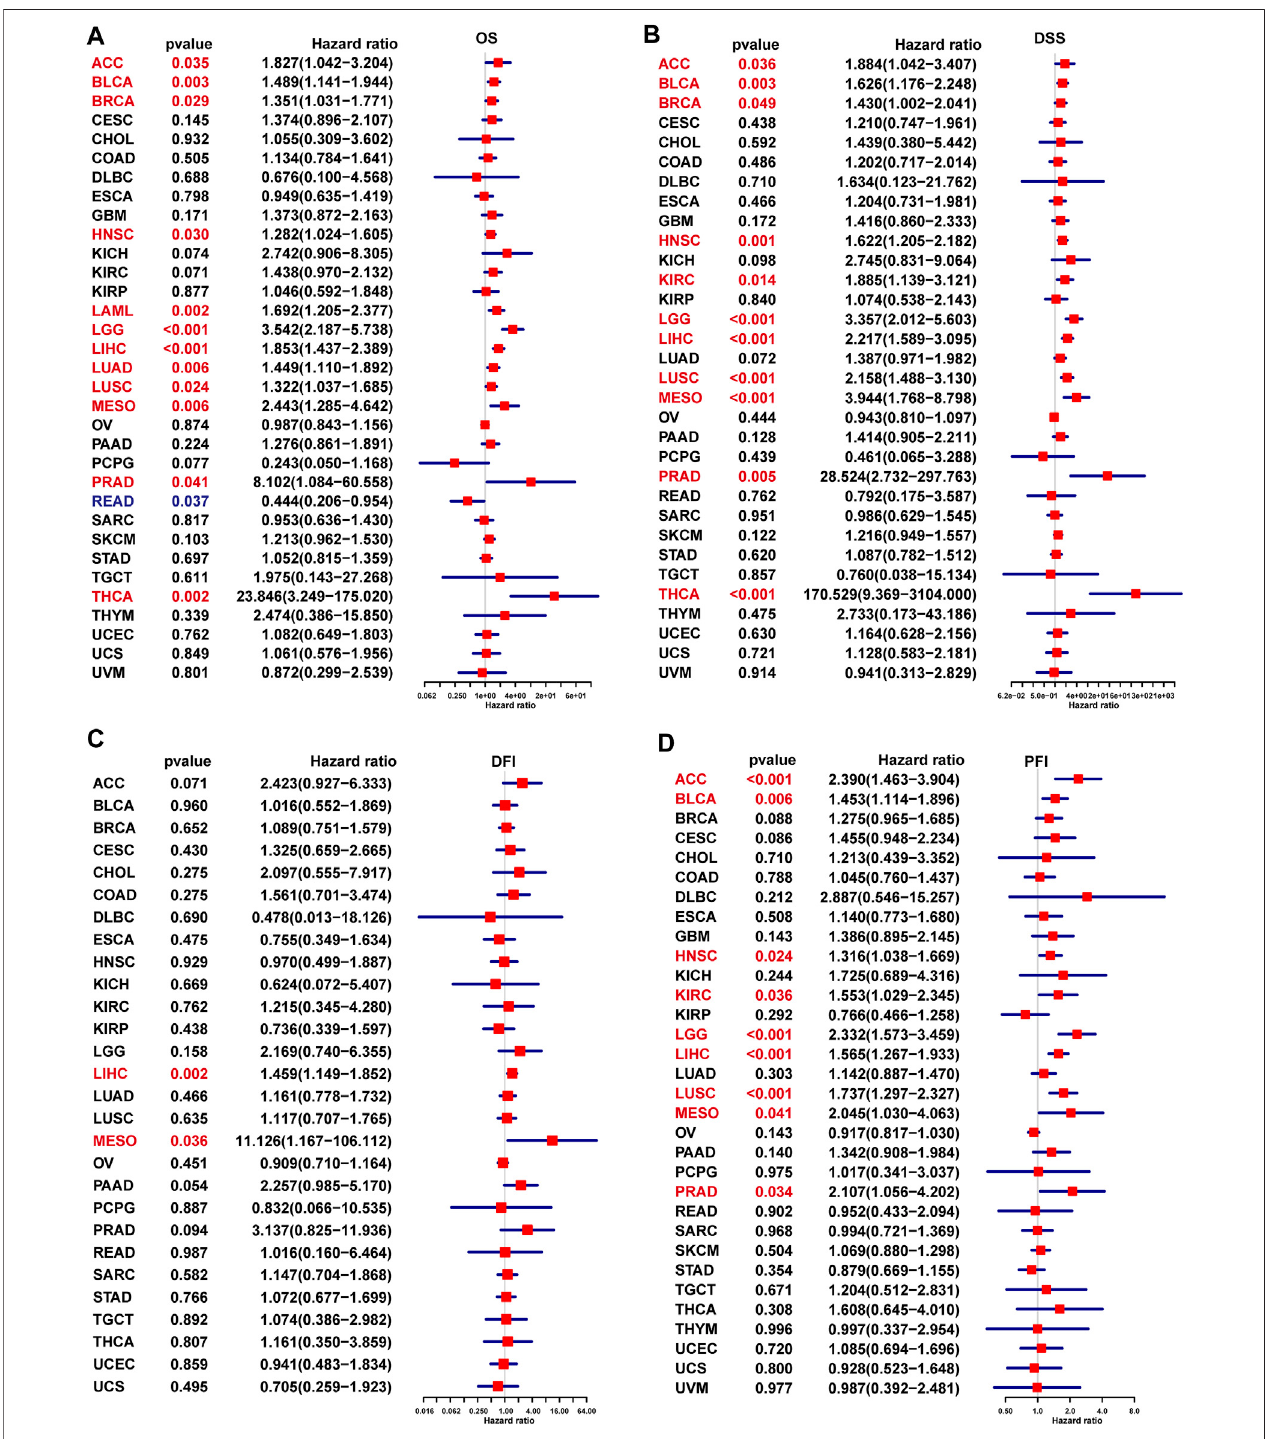
FIGURE5| Prognosticsigni fi canceofTPD52L2forOS,DSS,DFI,andPFIofpatients. (A – D) uniCoxresultsofTPD52L2inpan-cancerforOS (A) ,DSS (B) ,DFI (C) , and PFI (D) of patients. Red color represents signi fi cant results ( p < 0.05).